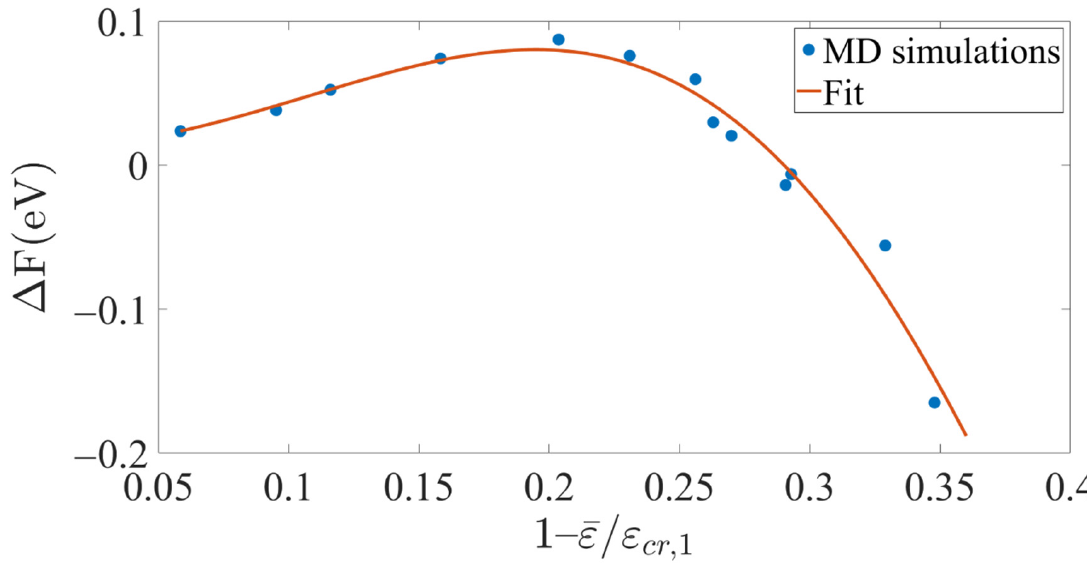
Figure 6. The difference in the activation energy between the two nucleation sites at the most probable nucleation strain for each temperature.